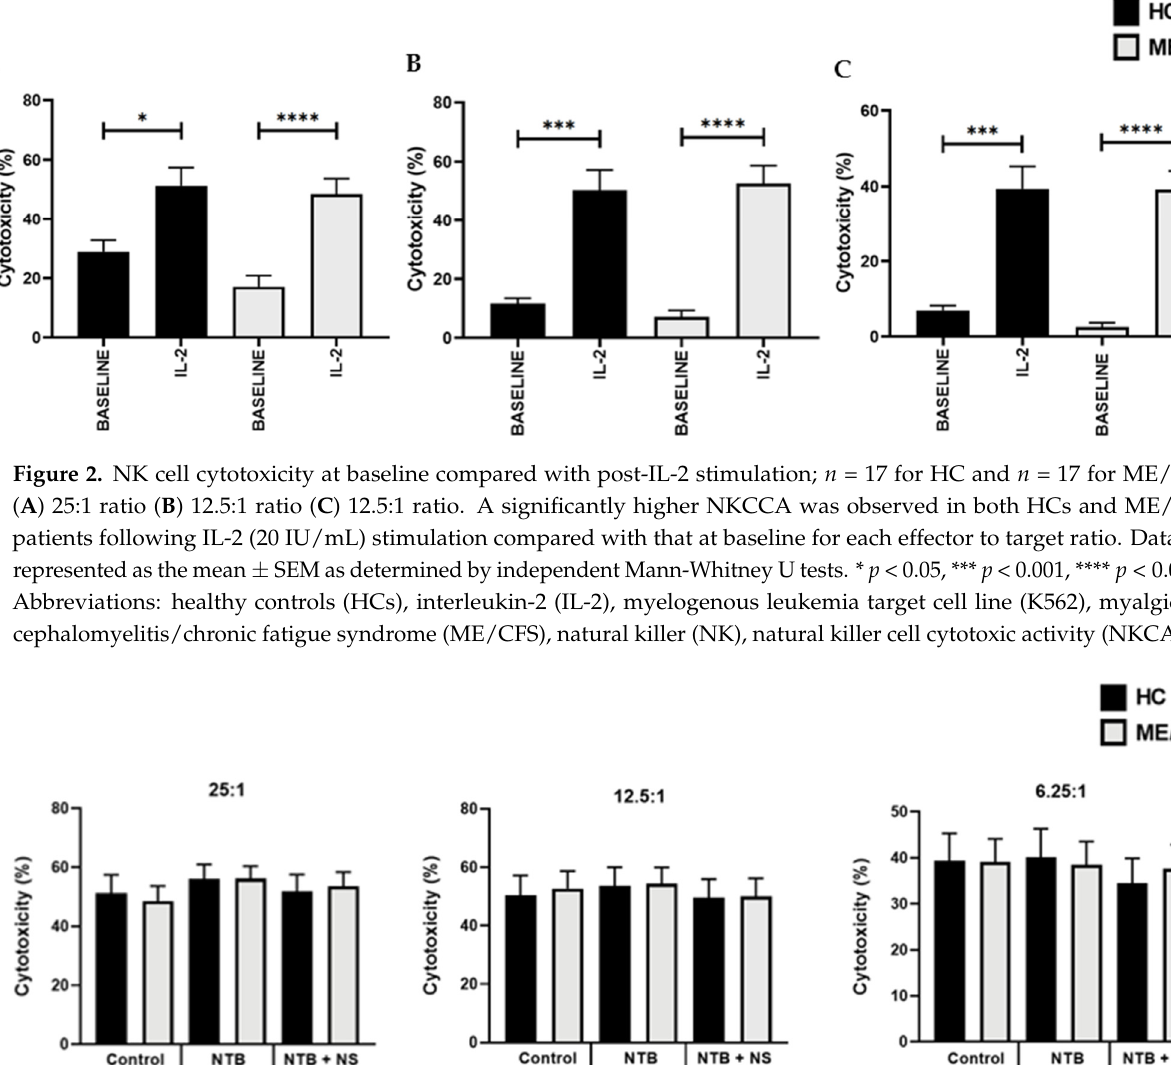
7 of 19 Figure 1. Baseline NK cell cytotoxicity; n = 17 for HC and n = 17 for ME/CFS. A significantly lower NKCCA was observed in ME/CFS patients compared with HCs at baseline for each effector to target ratio. Data are represented as the mean ± SEM as determined by independent Mann-Whitney U